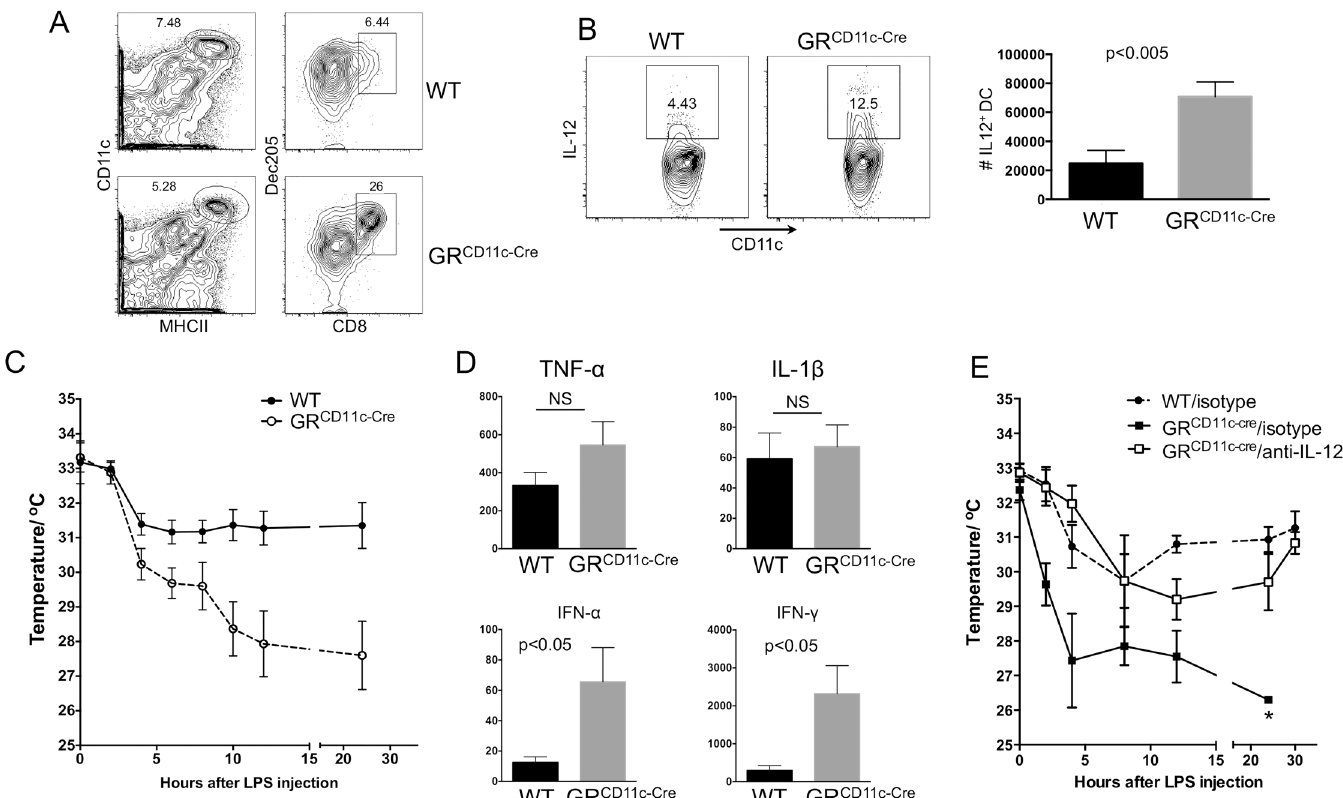
Fig 5. Loss of endotoxin tolerance in GR CD11c-cre mice. (A) Tolerizing dose of LPS-induced loss of CD8 + DCs in WT but not GR CD11c-cre mice. Mice were treated with 0.5 μ g/g body weight of LPS for 24 hr and rechallenged with 3 μ g/g body weight of LPS for 3 hr before splenic DCs were analyzed by flow cytometry. The experiment was repeated three times, with three mice in each group per experiment. (B) High-dose LPS induced IL-12 production by DCs in GR CD11c-cre mice despite prior exposure to low-dose LPS. Ten to twelve wk female GR CD11c-cre mice ( n = 4) and control mice ( n = 5) were treated with 0.5 μ g/ g body weight of LPS for 24 hr and rechallenged with 10 μ g/g body weight of LPS for 6 hr. Percentage of IL-12 + DCs in the spleen of a representative mouse is shown (left panel). Average numbers of total IL-12 + DCs were calculated based on the total number of splenocytes in each mouse (right panel). (C) Body temperature of mice rechallenged with 10 μ g/g body weight of LPS 24 hr after tolerization. Results were pooled from two independent experiments, n = 8 for WT and n = 5 for GR CD11c-cre . (D) Serum levels of TNF- α , IL-1 β , IFN- α , and IFN- γ from mice in (B) were measured 6 hr after rechallenge. (E) Body temperature of mice rechallenged with 10 μ g/g body weight LPS 24 hr after tolerization and 1 hr after injection with 250 μ g anti-IL-12 or isotype control. Results were pooled from two independent experiments with one to two mice per condition, respectively, n = 3 per condition. The asterisk indicates the time by which all GR CD11c-cre mice had died. All WT and the GR CD11c-cre animals treated with anti-IL-12 survived. The data used to make this figure can be found in S1 Data.